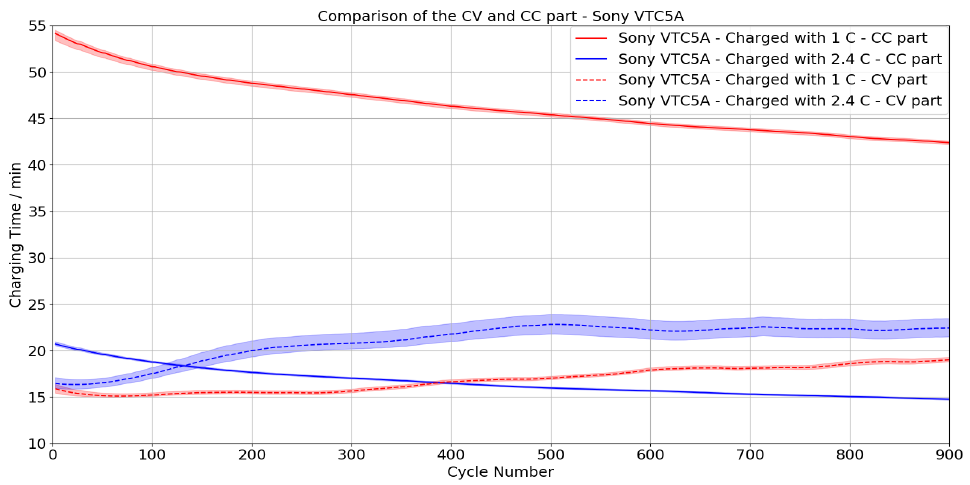
Figure 15. Development of the charging time during the cycle test. Separation of the CC and CV part for Sony VTC5A. Table 4. Proportion of the total load and loading time of the CC part after the first cycle. Table 6. Proportion of the total load and loading time of the CC part after 500 cycles.